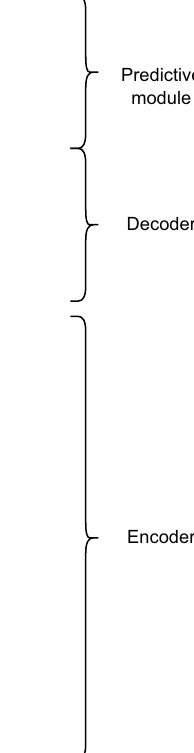
Fig. 4 | The autoencoder architecture. The structure of the task-adapted auto- encoder. The encoder module generates a learned representation for each input sequence; the decoder module tries to reconstruct the input sequence, while the